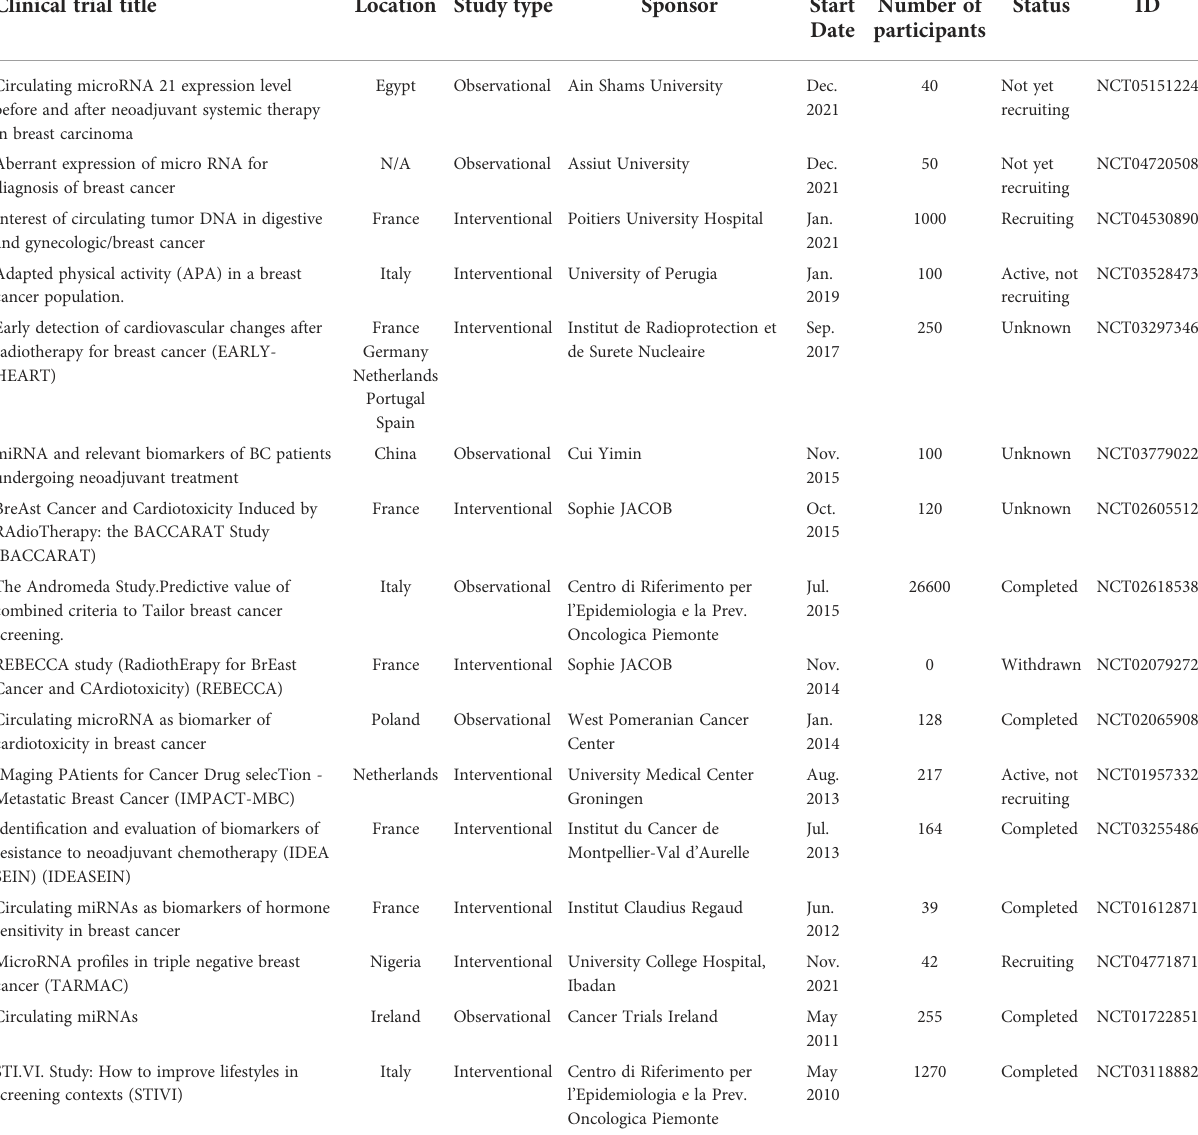
TABLE 4 Clinical trials on breast cancer involving circulating miRNAs (sorted by study start